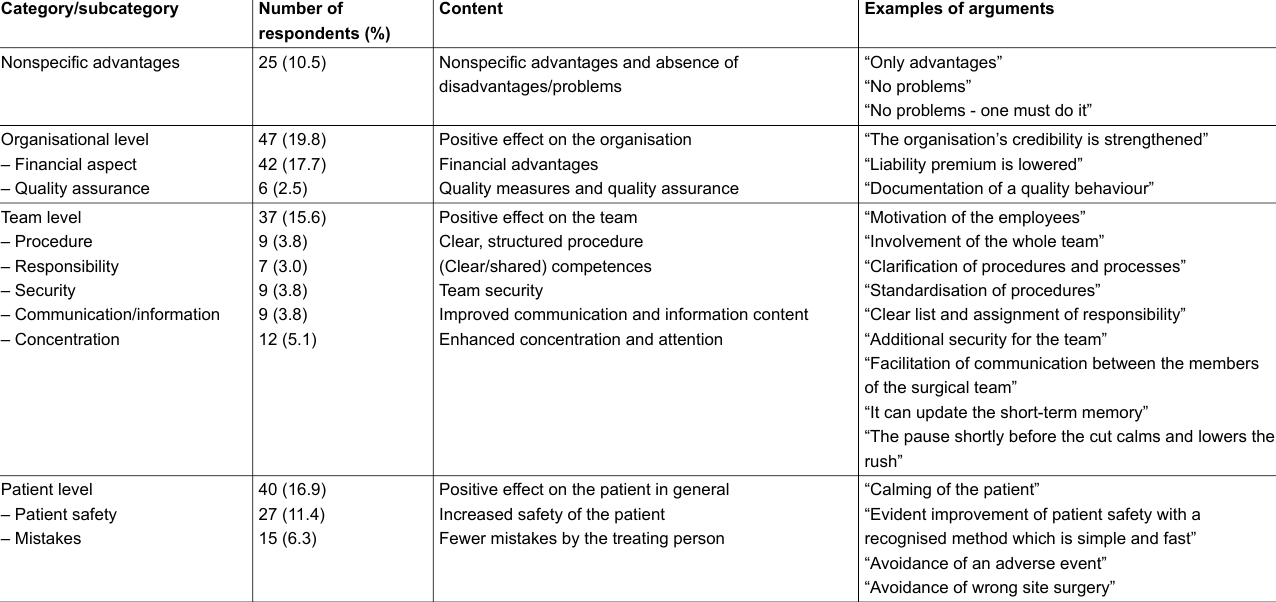
Table 3: Examples of arguments for the advantages of introducing and implementing surgical safety checklists and the number of respondents per category (n = 237). Category/subcategory Number of respondents (%)